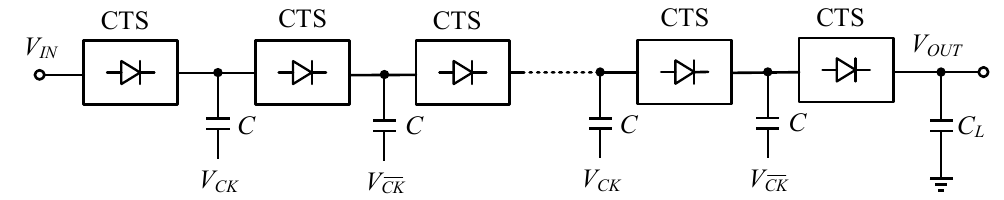
Figure 2. Simplified scheme of a linear Dickson charge pump.